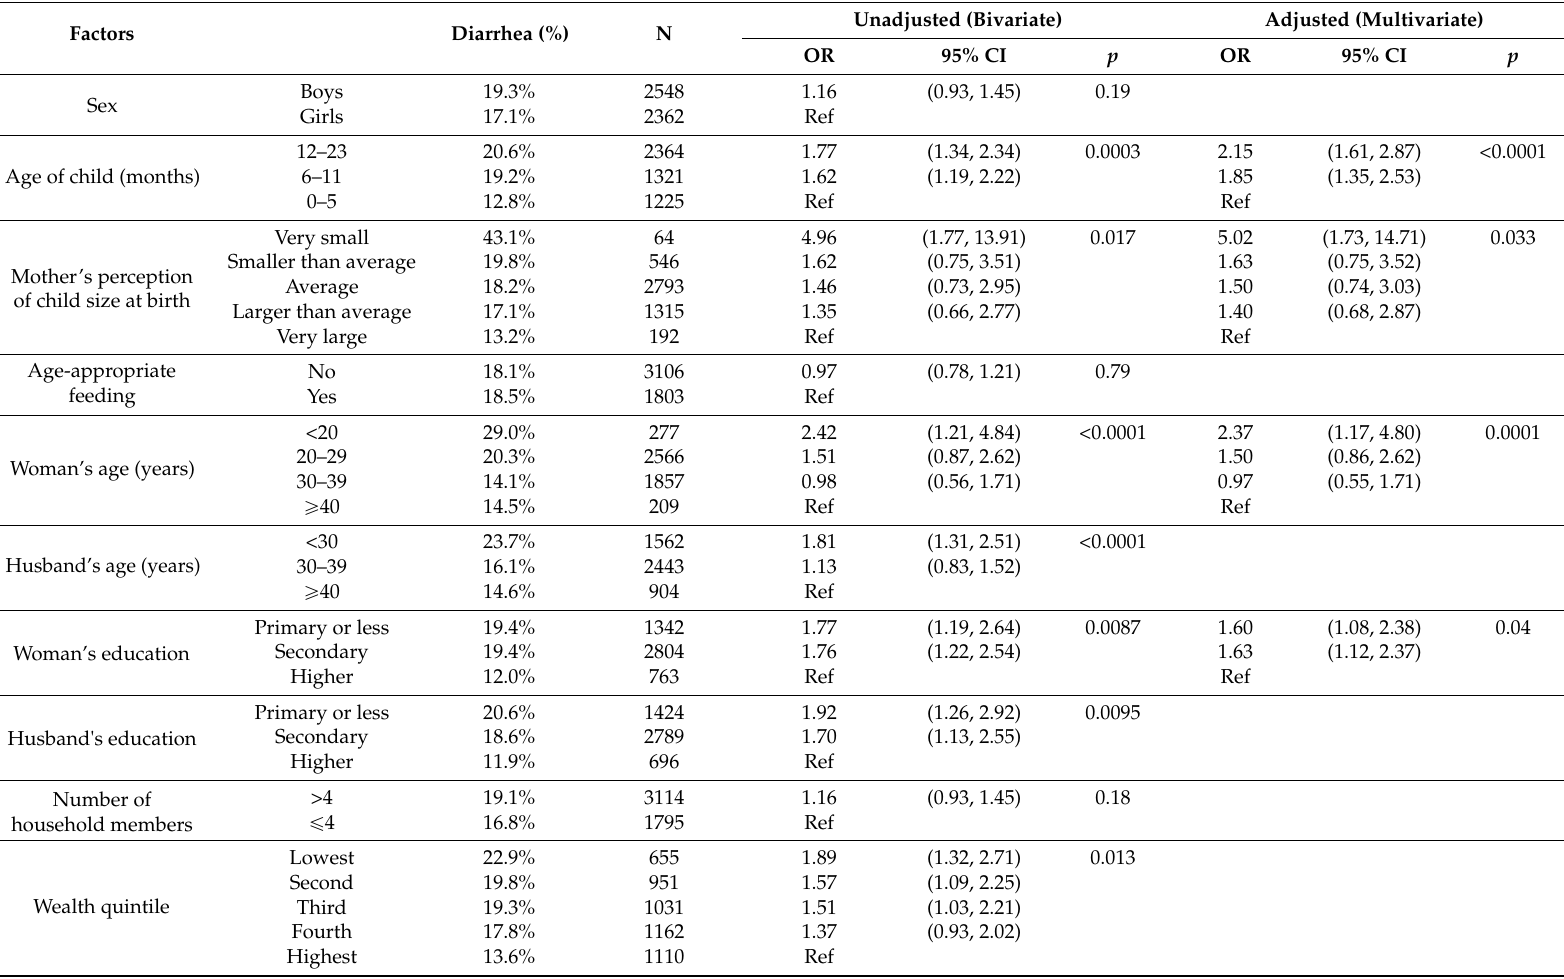
Table 2. Odd Ratio (OR) for risk factors for diarrhea in children aged 0–23 months in Indonesia ( N =